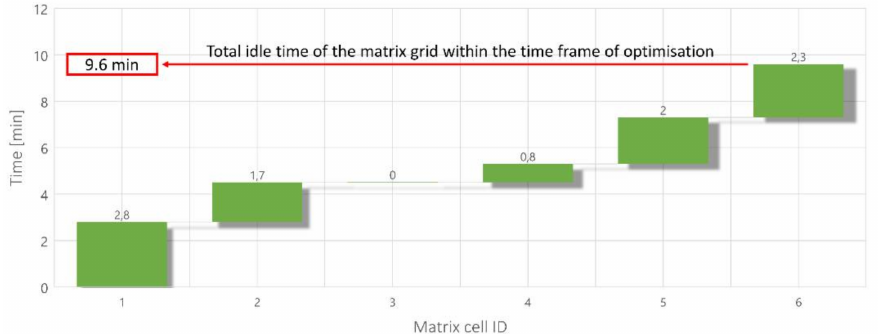
Figure 6. Idle time distribution among matrix cells within the cycle time of the 16 production orders in scenario